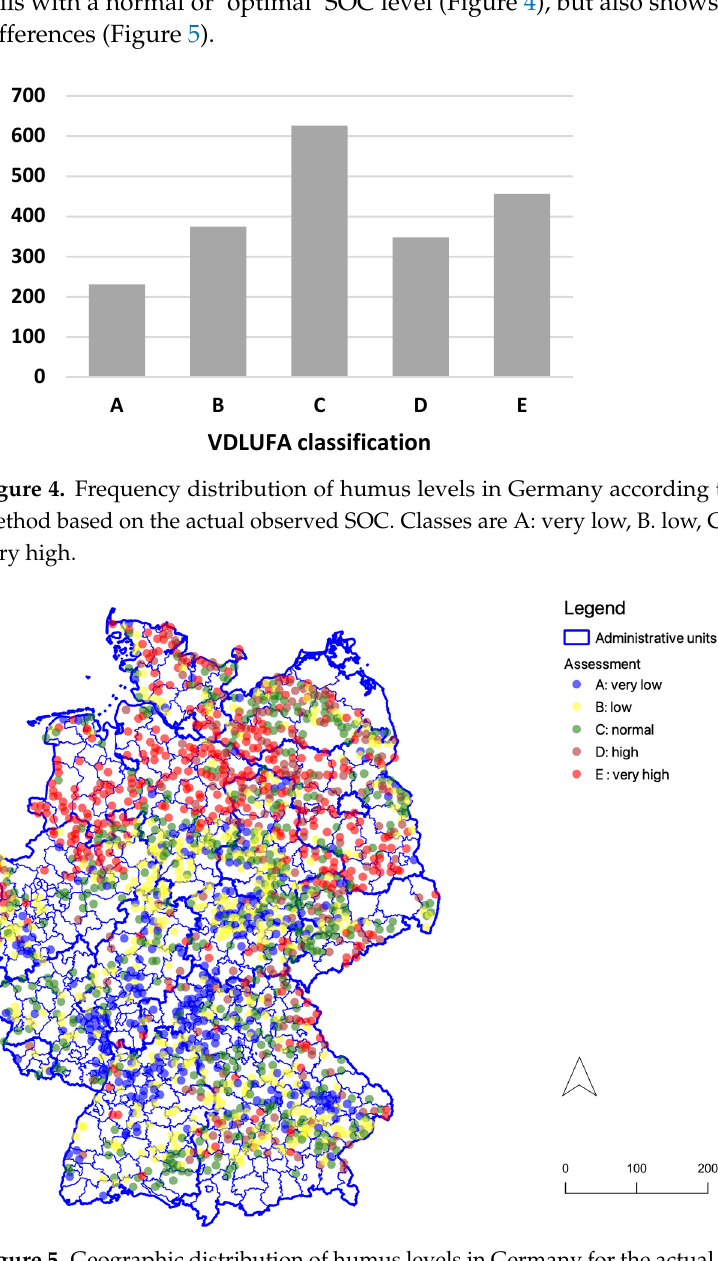
Figure 5. Geographic distribution of humus levels in Germany for the actual observed SOC according to the VDLUFA balance method. Dots represent BZE sampling points. Assessment classes are according to the VDLUFA method as shown in Table 2.